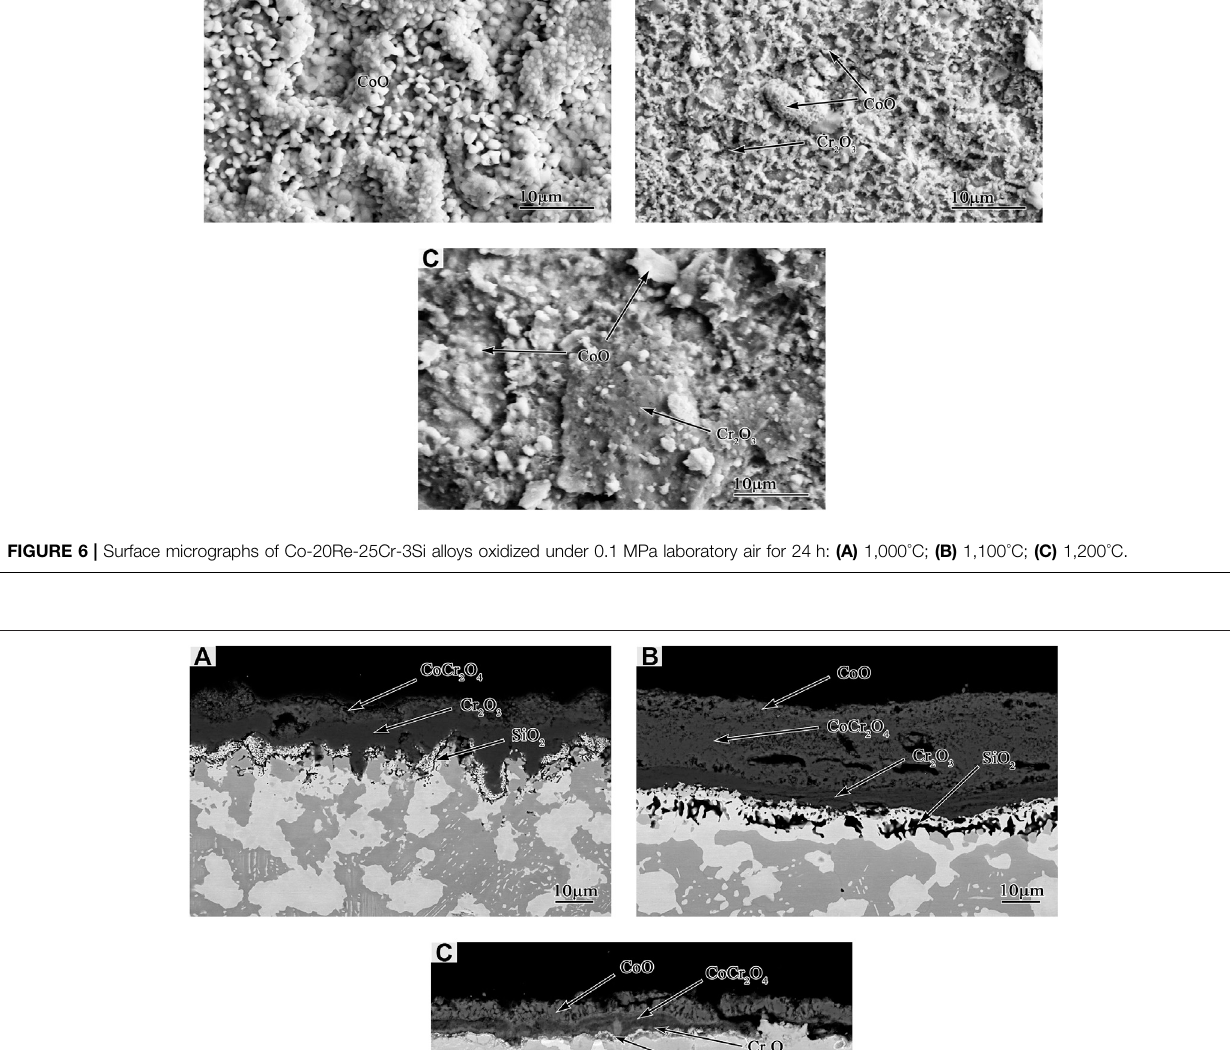
Frontiers in Materials |